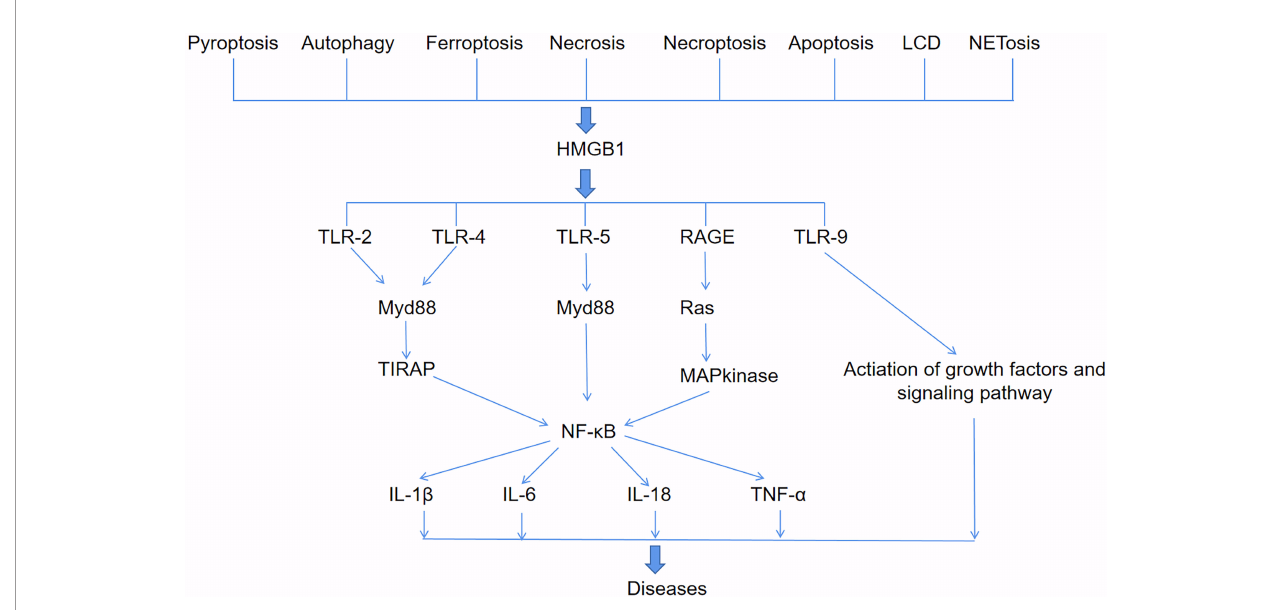
FIGURE 2 | HMGB1-involved signaling pathways. HMGB1 can be passively released during various types of cell death, such as pyroptosis, autophagy, ferroptosis, necrosis, necroptosis, apoptosis, lysosome-dependent cell death (LCD) and NETosis. HMGB1 binds to TLR2, TLR4, TLR5, RAGE and TLR9 receptors to activate downstream pathways that produce pro-in fl ammatory cytokines such as IL-1 b , IL-6, IL-18, and TNF- a , and lead to